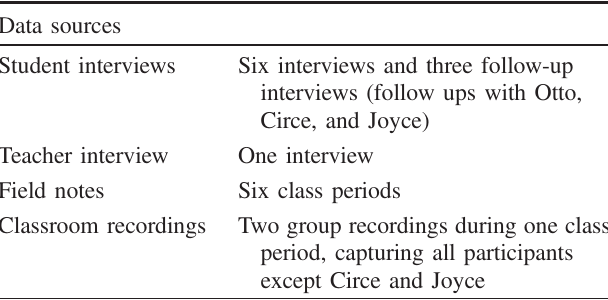
TABLE I. Four types of data sources: Student interviews, a teacher interview, field notes, and classroom recordings. Data sources Student